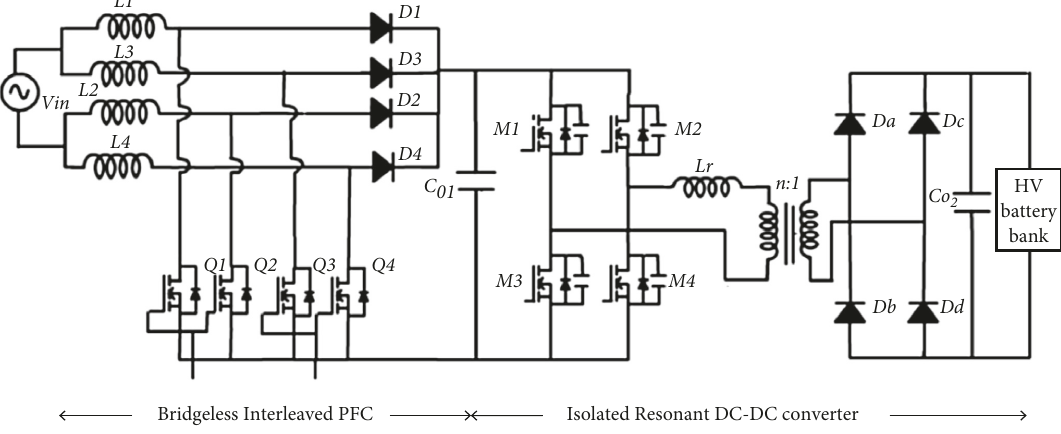
Figure 2: Proposed battery charger